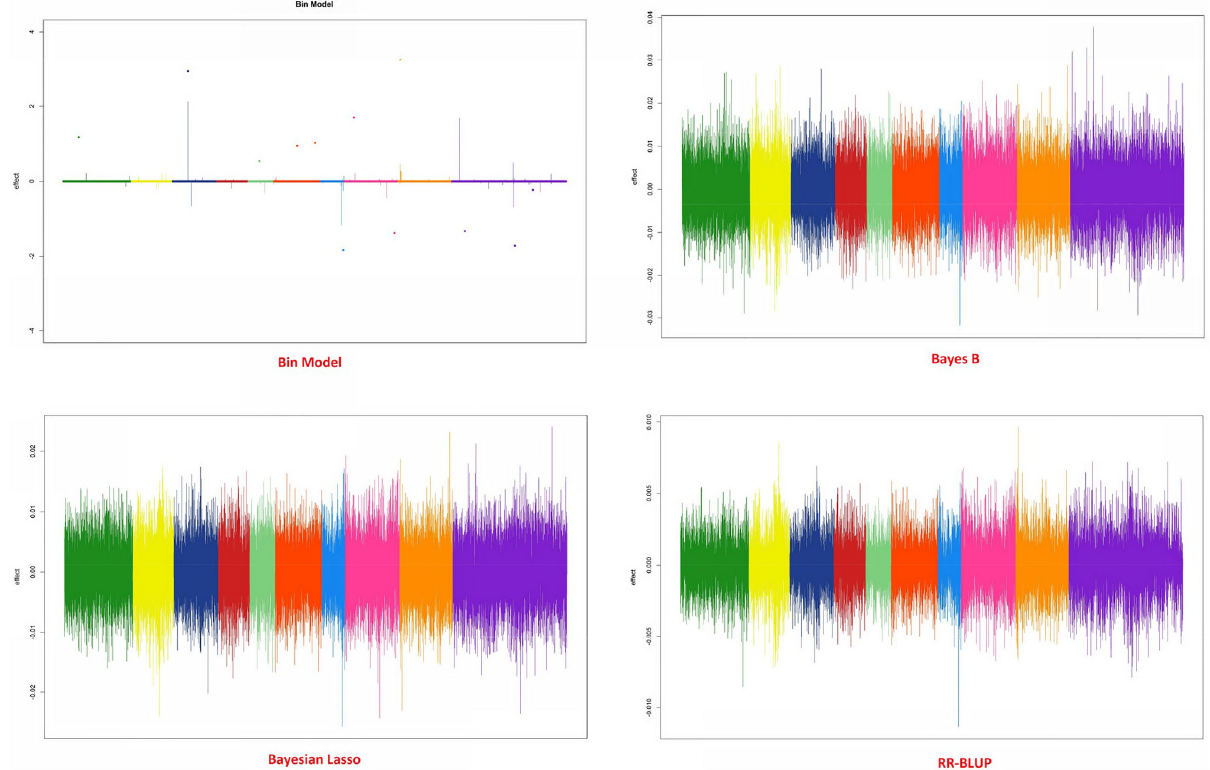
Fig 9. Genomic profile relates to 611 Eucalyptus plants simulated from the 36,812 SNPs obtained the real data. The models used were the Bin 0.01, Bayesian Lasso, Bayes B and RR-BLUP models. The dots represent the position e effects of simulated genes.